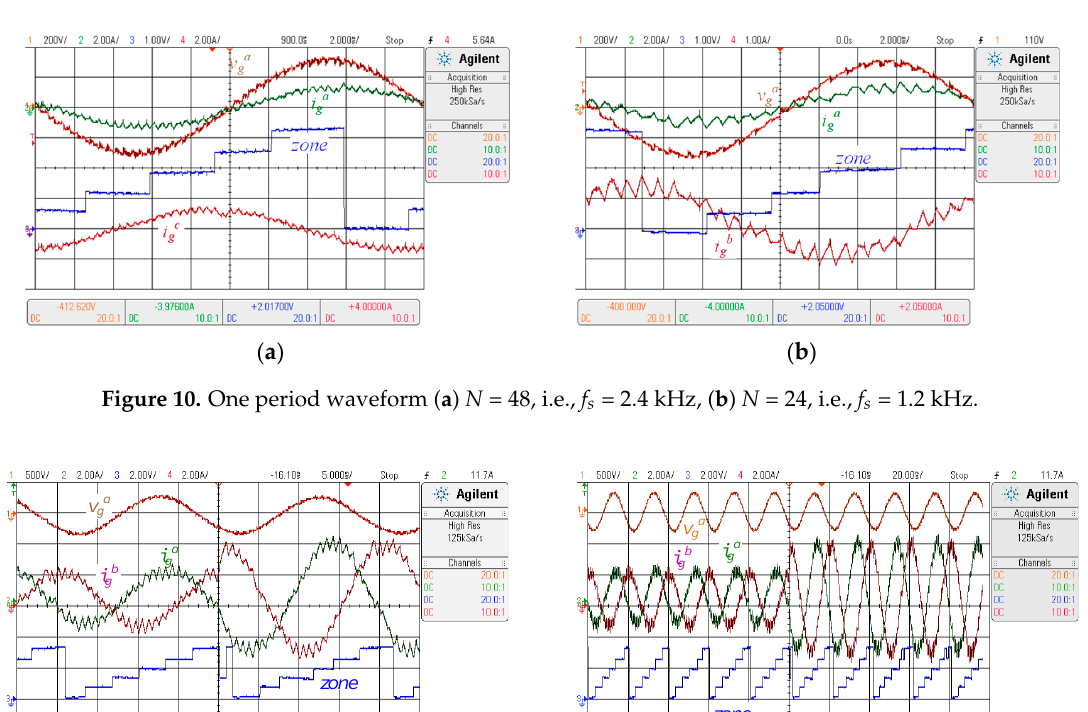
Figure 9. Frequency response ( a ) N = 48, i.e., f s = 2.4 kHz, ( b ) N = 24, i.e., f s = 1.2 kHz.